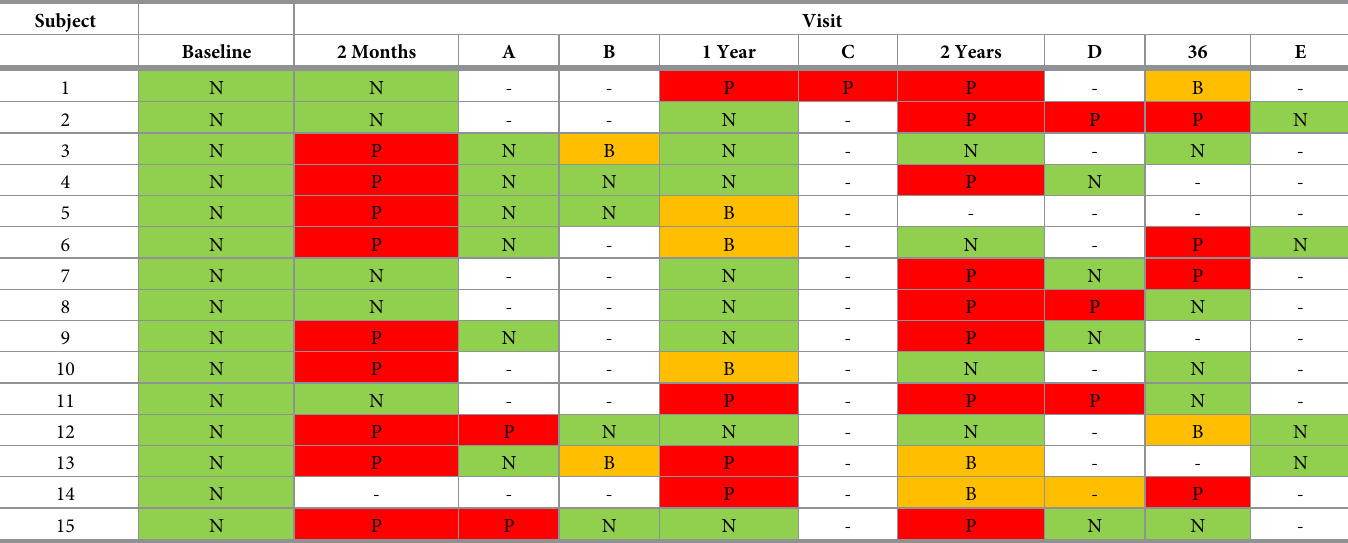
Table 7. Results of serial IGRAs performed among 15 subjects who met criteria for irregular converters.